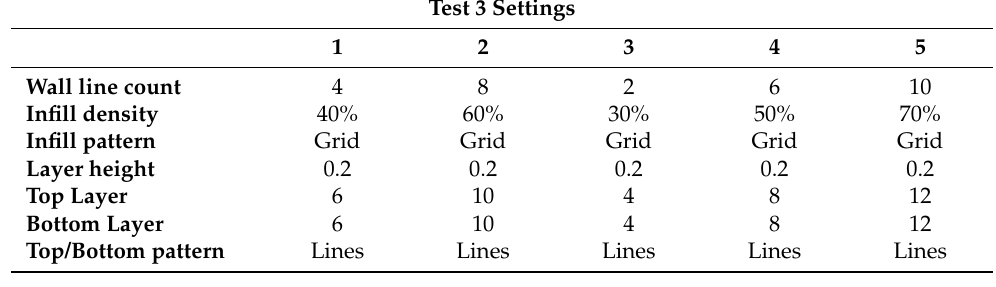
Table 7. Punch settings of Test 3.